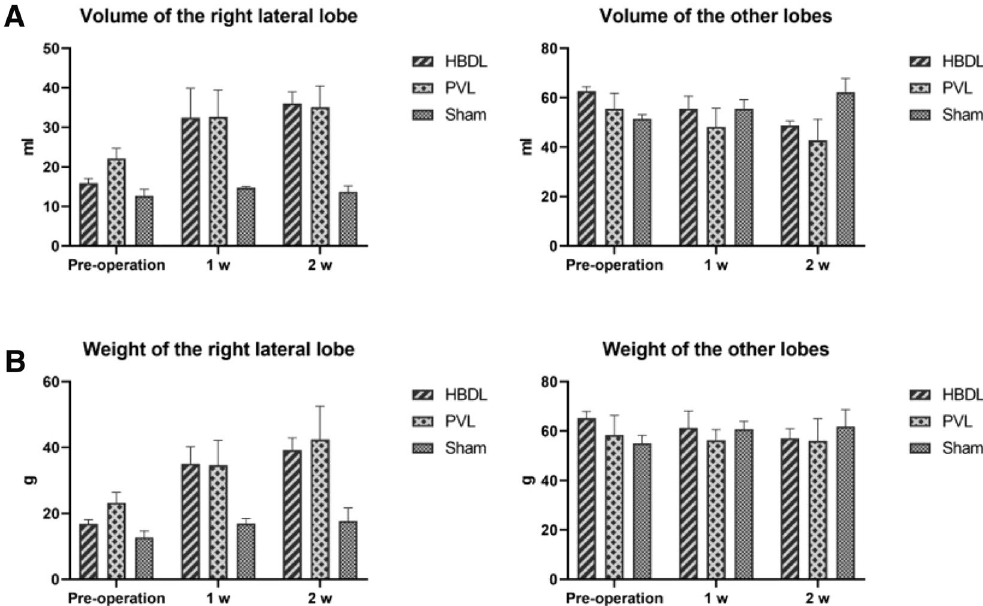
Figure 1. Changes in the volume of the right lateral lobe and the remaining liver lobes in the three groups of rabbits at different time points ( A ); changes in the weight of the right lateral lobe and the remaining liver lobes in the three groups of rabbits at different time points ( B